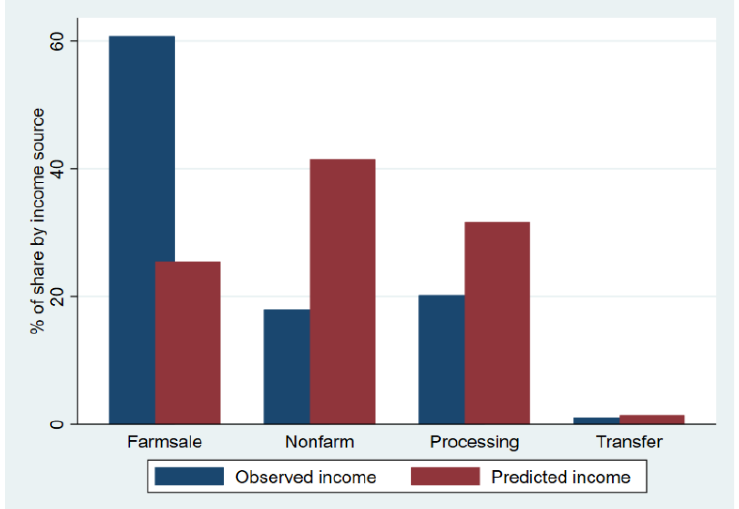
Figure 2. Original contribution of each source to income inequality.